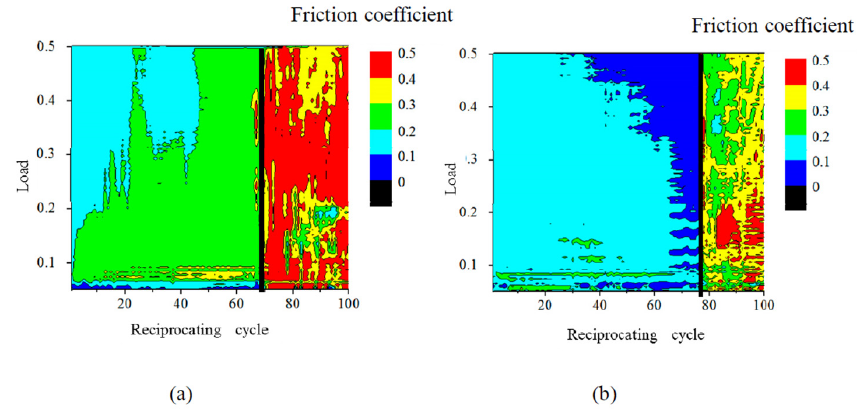
Figure 8. Contour plot and overhead view of cluster analysis data for friction coefficient of P-CVD-DLC film. ( a ) RT; ( b ) 200 °C